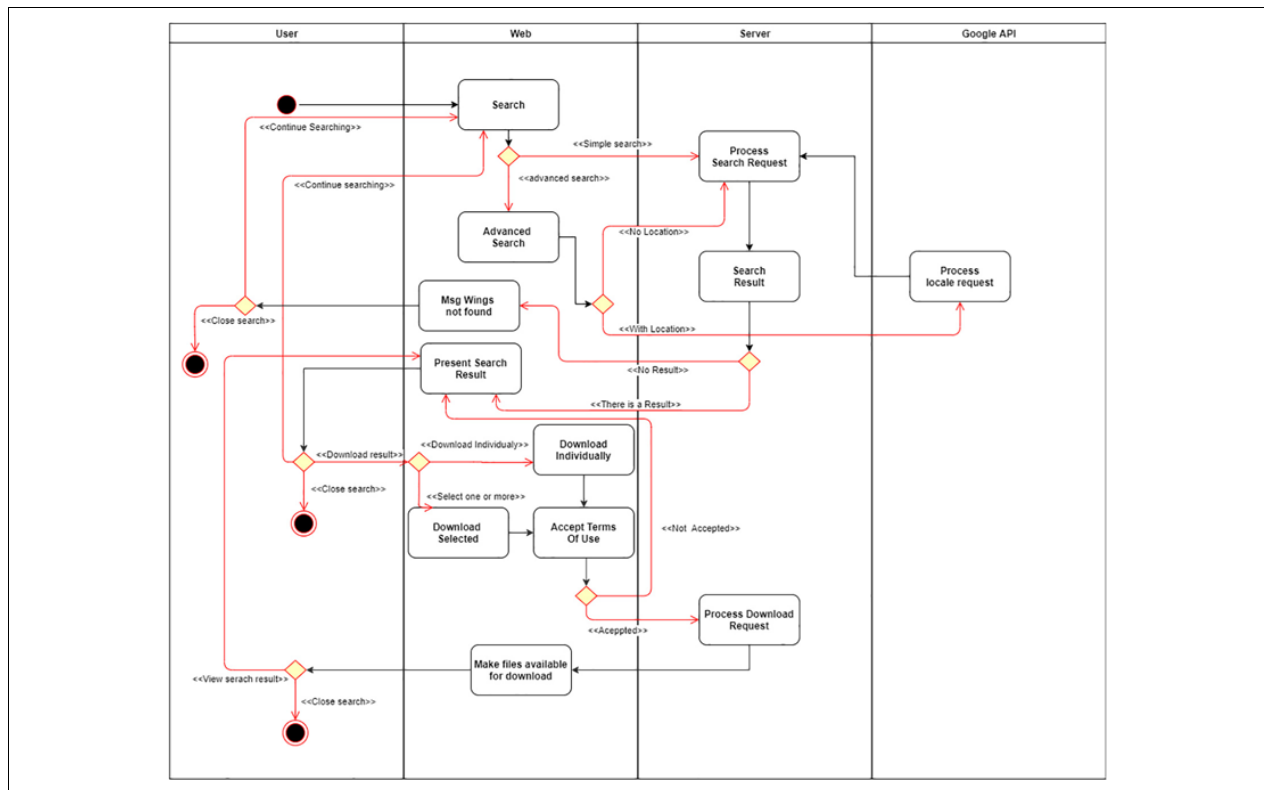
FIGURE 4 | Activity diagram for the WingBank platform search system.